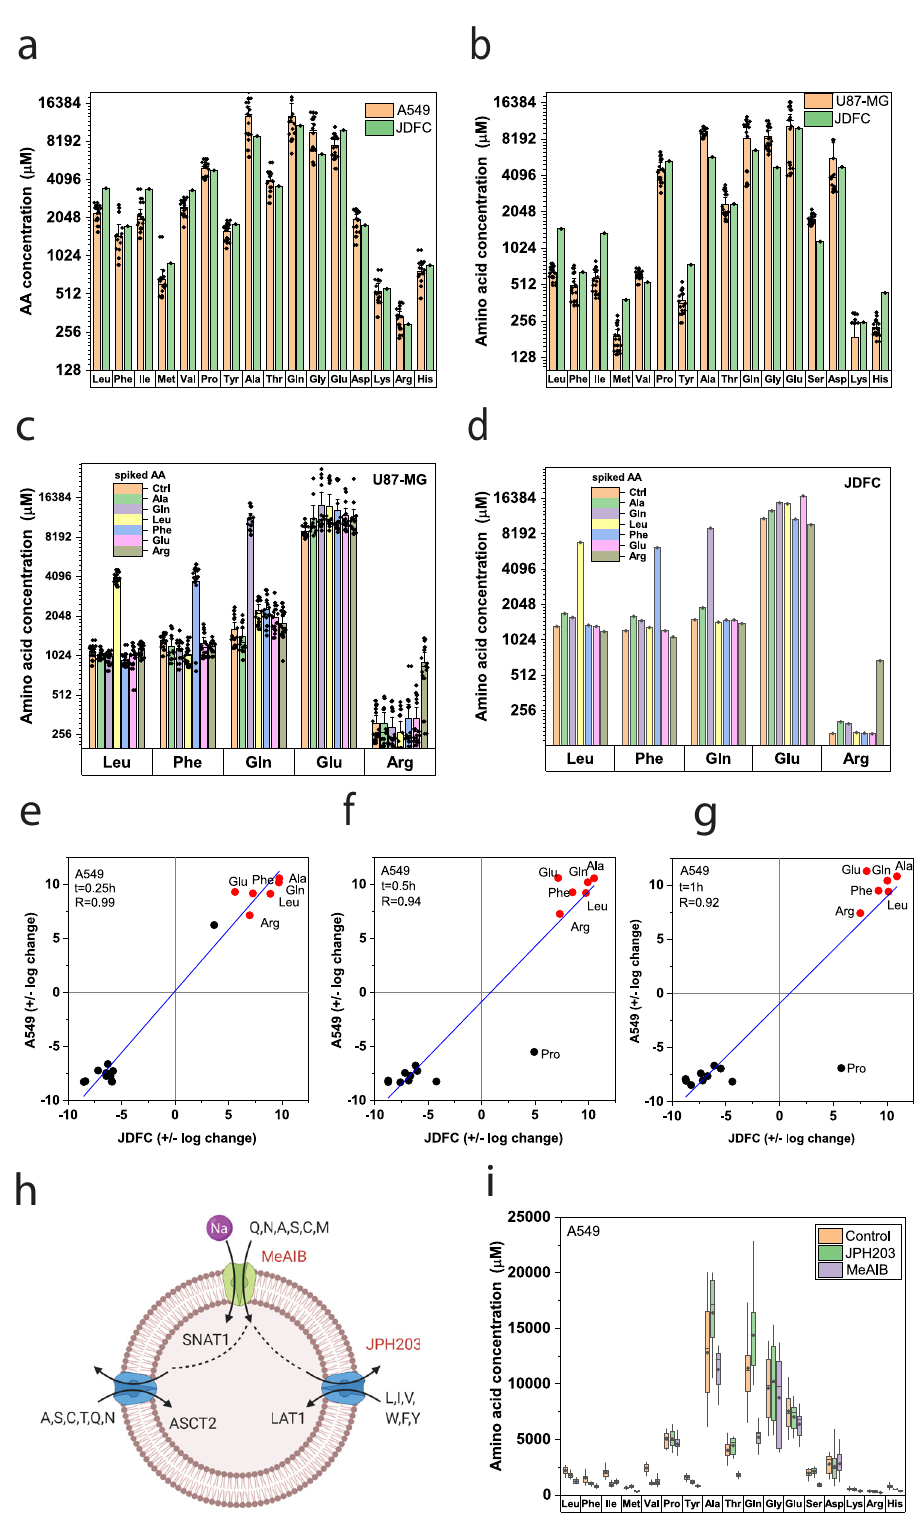
increase of the cytosolic concentrations (red dots), while non- spiked amino acids served as ef fl ux substrates ending up in the lower left quadrant (black dots). The simulation and experimental data showed a strong correlation of R = 0.99, 0.94, and 0.92 at t = 0.25 h (Fig. 6e), 0.5 h (Fig. 6f), and 1 h (Fig. 6g), respectively. In U87-MG cells, experimental and predicted absolute amino acid concentrations showed a high level of correlation with R = 0.95,